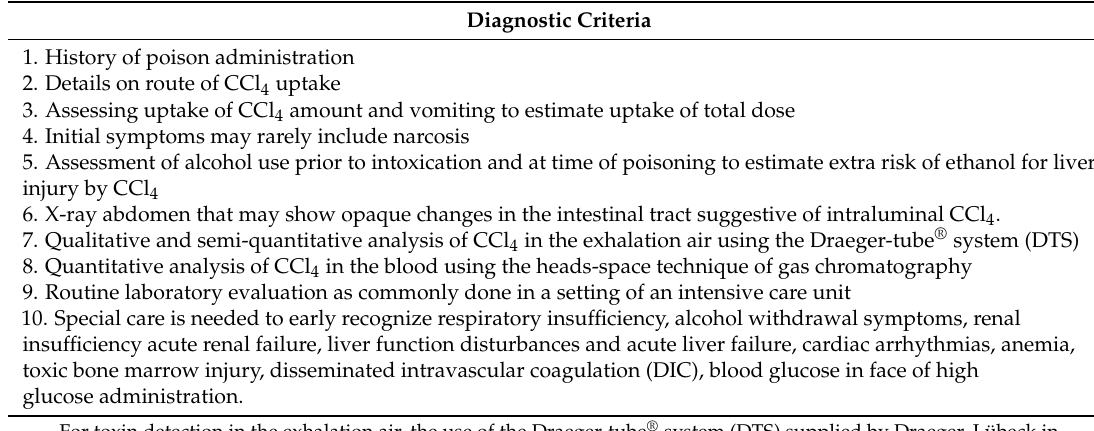
Table 3. Diagnosis of liver injury by acute CCl 4 intoxication.